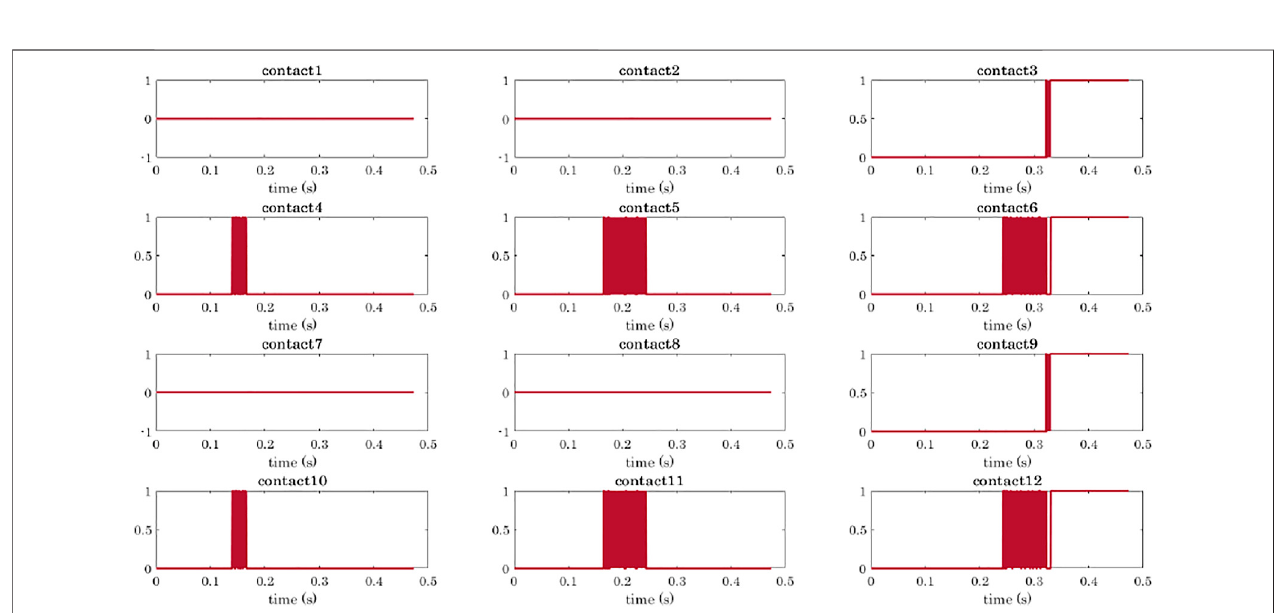
FIGURE8| Powergraspofaspherewiththefour- fi ngeredgripper:trajectoriesofthejoints.Plotsareorderedasthephalangesofthehand:therowscorrespondto the fi ngers (from 1 to 4), and the columns to the phalanges (from 1 to 3).